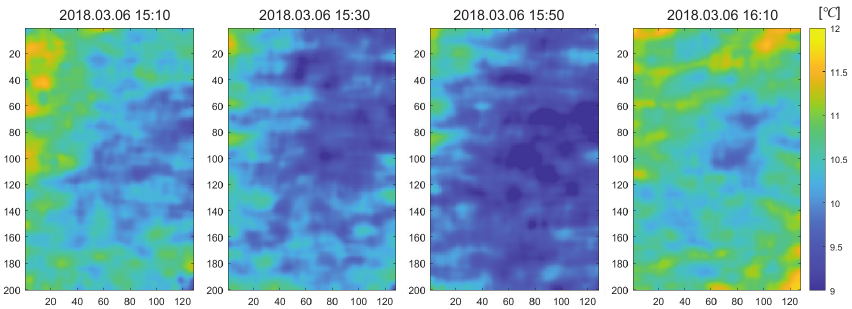
Figure 24. VisualAT-based dynamic temperature images measured at different times (20-min. intervals): Temporal variation of air temperature distribution can be found.